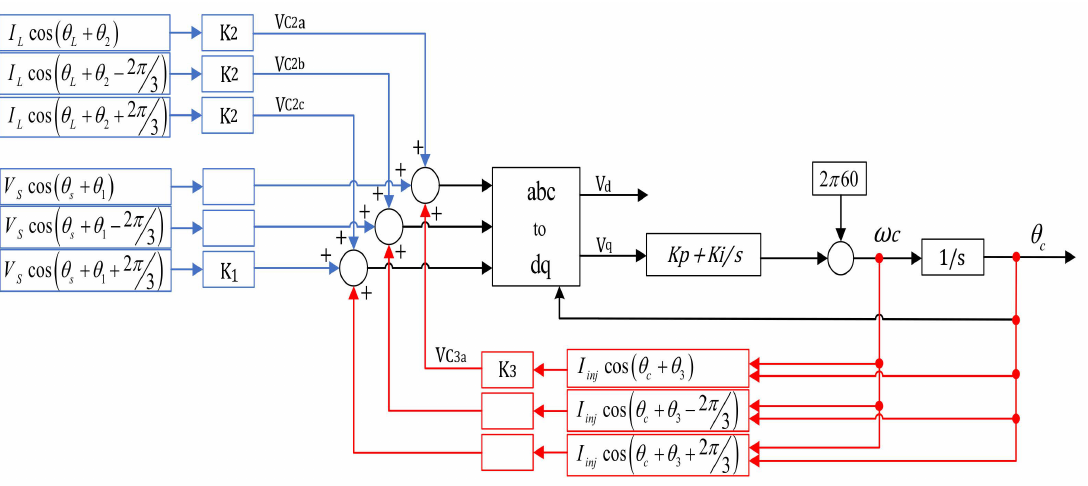
Figure 6. PLL model by considering system operation and grid